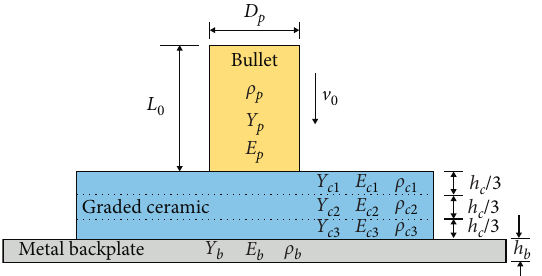
Figure 1: Simplified one-dimensional analysis model of a bullet impacting a ceramics-metal